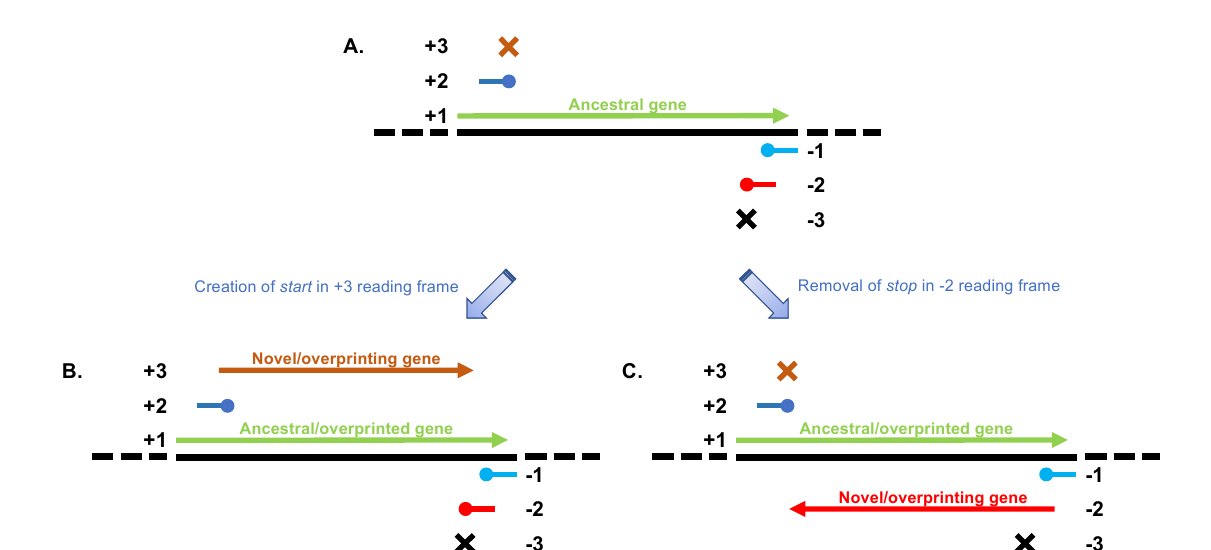
Figure 1. De novo creation of genes by overprinting. Typically, genomic regions contain a single gene encoding a protein product in one of the 6 reading frames (for example, reading frame +1 in panel ( A ). The same genomic region does not encode any protein in the other 5 reading frames, either because of absence of start codons (as in reading frame +3 and − 3, marked with × ) or because of the presence of stop s shortly after a start codon (as in reading frames +2, − 1 and − 2, marked with • ). The occurrence of single point mutations in one of these 5 reading frames can give rise to a new protein-coding gene, either by creating a new start codon (as in reading frame +3 in panel ( B ) or by eliminating a stop codon (as in reading frame − 2 in panel ( C ). When this occurs, the original gene is called ‘ancestral’ or ‘overprinted’, while the new one is called ‘novel’ or ‘overprinting’. In rare cases, both events can occur over time (as in the case of HTLV-1 and HIV-1), thus giving rise to genomic regions that contain three overlapping protein-coding genes.